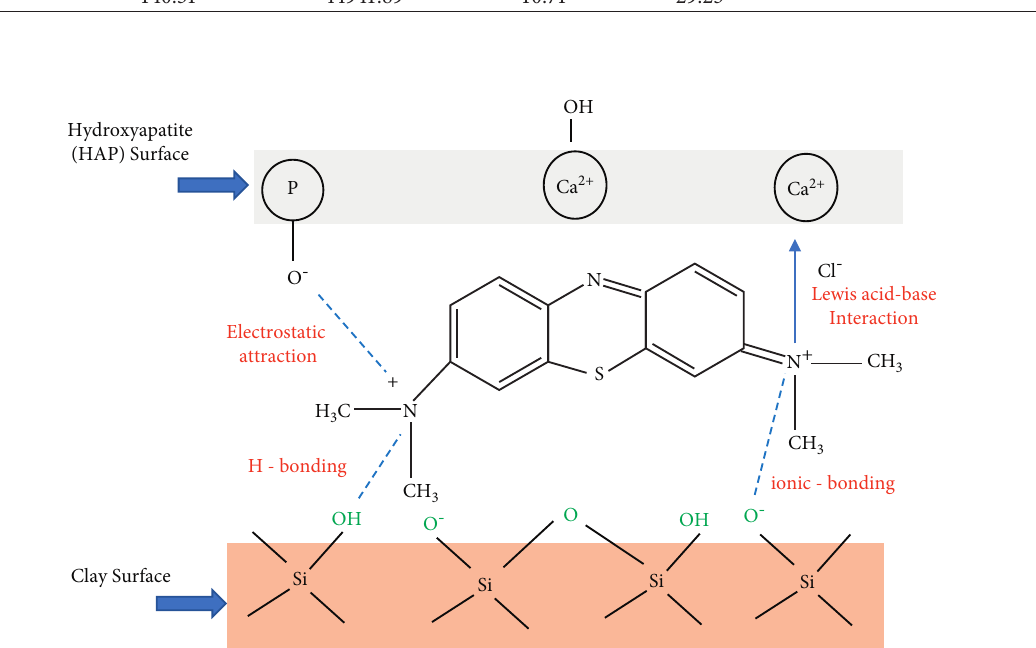
Figure 11: Schematic representation of proposed MB adsorption mechanism on HAP:clay